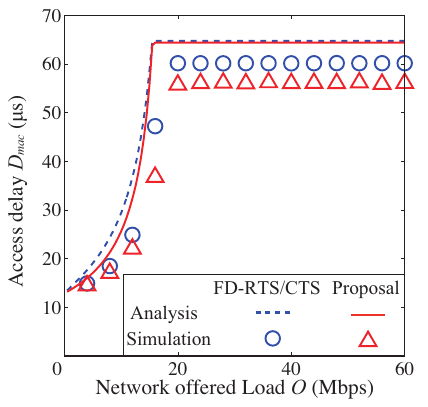
Figure 11. Access delay as a function of offered load, the case of no packet